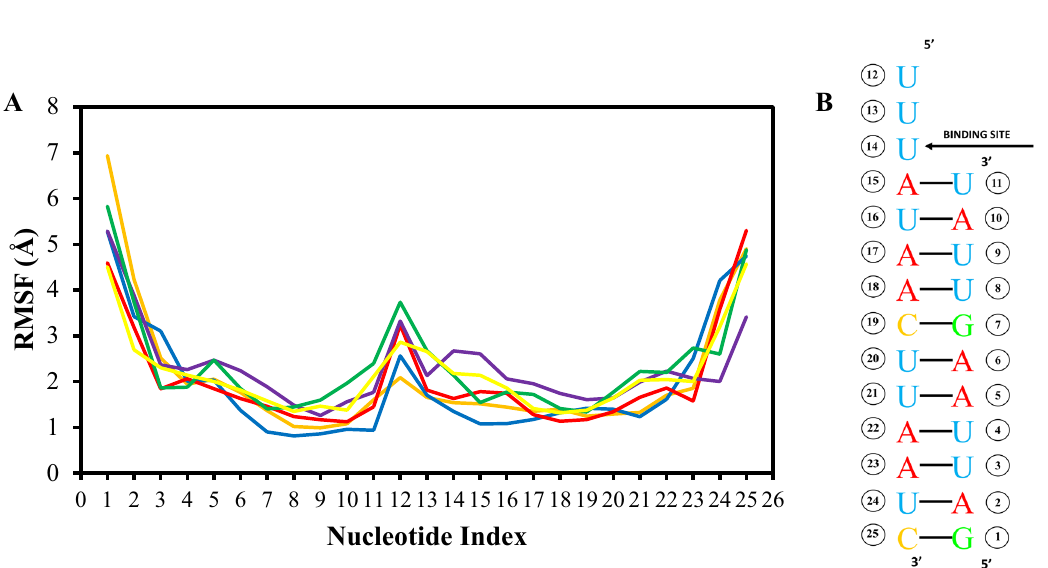
Figure 7. RMSF values of the template-primer RNA O5 ′ atoms of the ATP, RTP and four ZINC compound systems ( A ) and a guide displaying nucleotide indexing values respective to the nucleotide positions on the RNA chain ( B